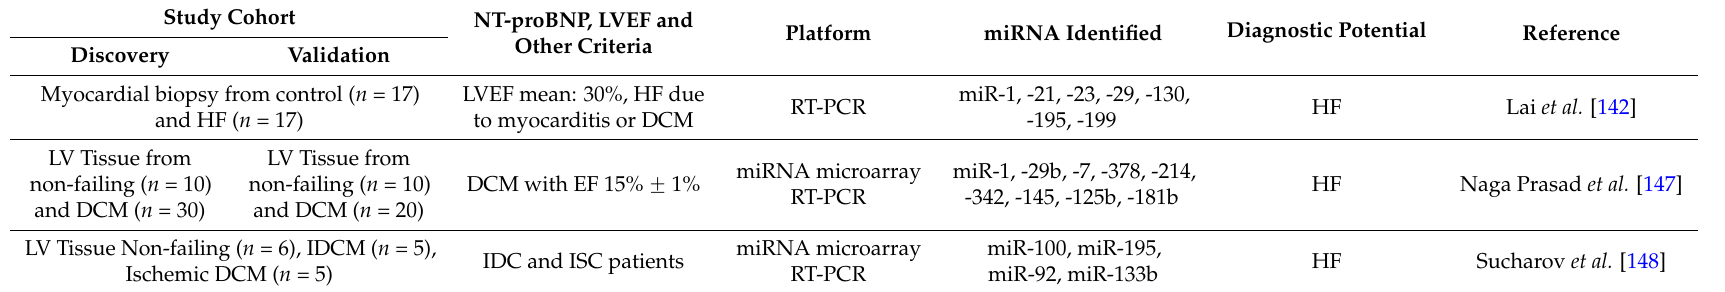
Table 7. Summary of reported miRNAs as HF biomarkers in cardiac tissues/biopsy samples.